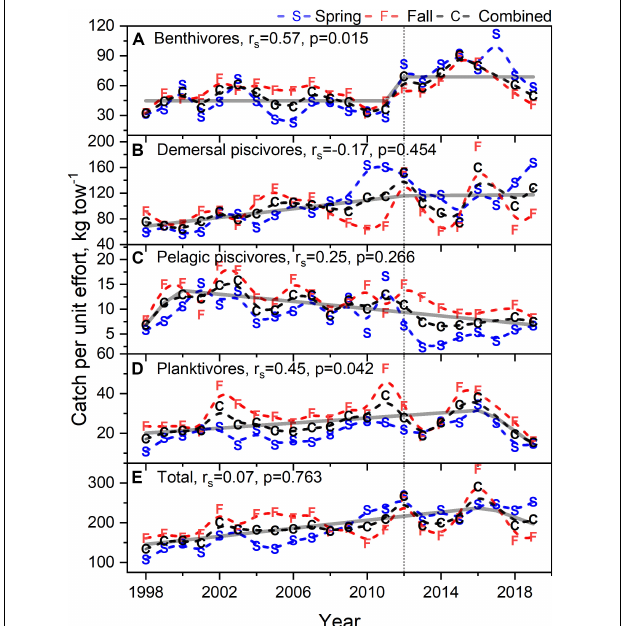
FIGURE 10 | Biomass as catch per unit effort for benthivores (A) , demersal piscivores (B) , pelagic piscivores (C) , planktivores (D) , and total biomass (E) during spring and fall time frames. Dashed black line is mean of spring and fall curves. In each caption, r s is the Spearman correlation with associated p -value. Dashed line are b-splines; solid line either STARS or segmented regression models; vertical dotted line marks